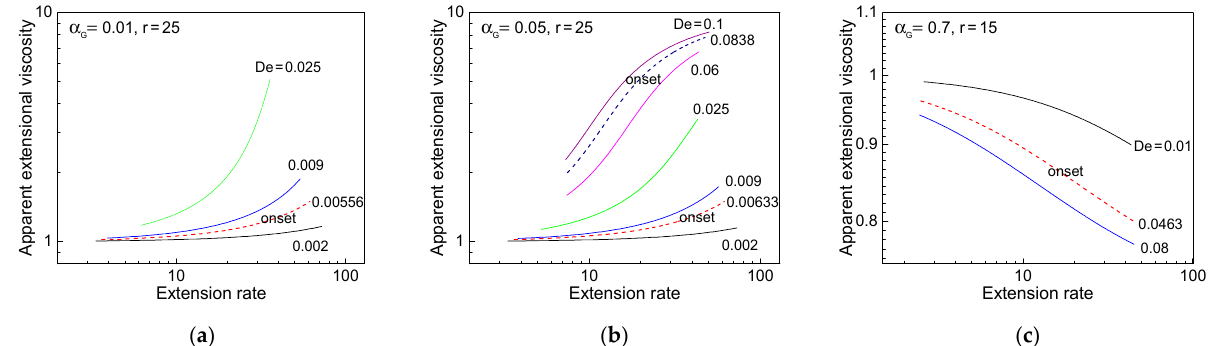
Figure 4. Apparent extensional viscosity in the spinline with respect to extension rate under several material parameter conditions: ( a ) α G = 0.01, r = 25, ( b ) α G = 0.05, r = 25, and ( c ) α G = 0.7, r =